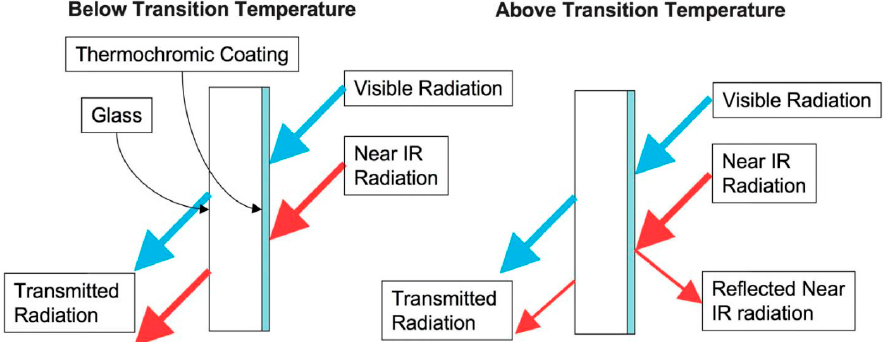
Figure 12. Schematic of thermochromic behaviour of thermochromic vanadium dioxide glazing [62].